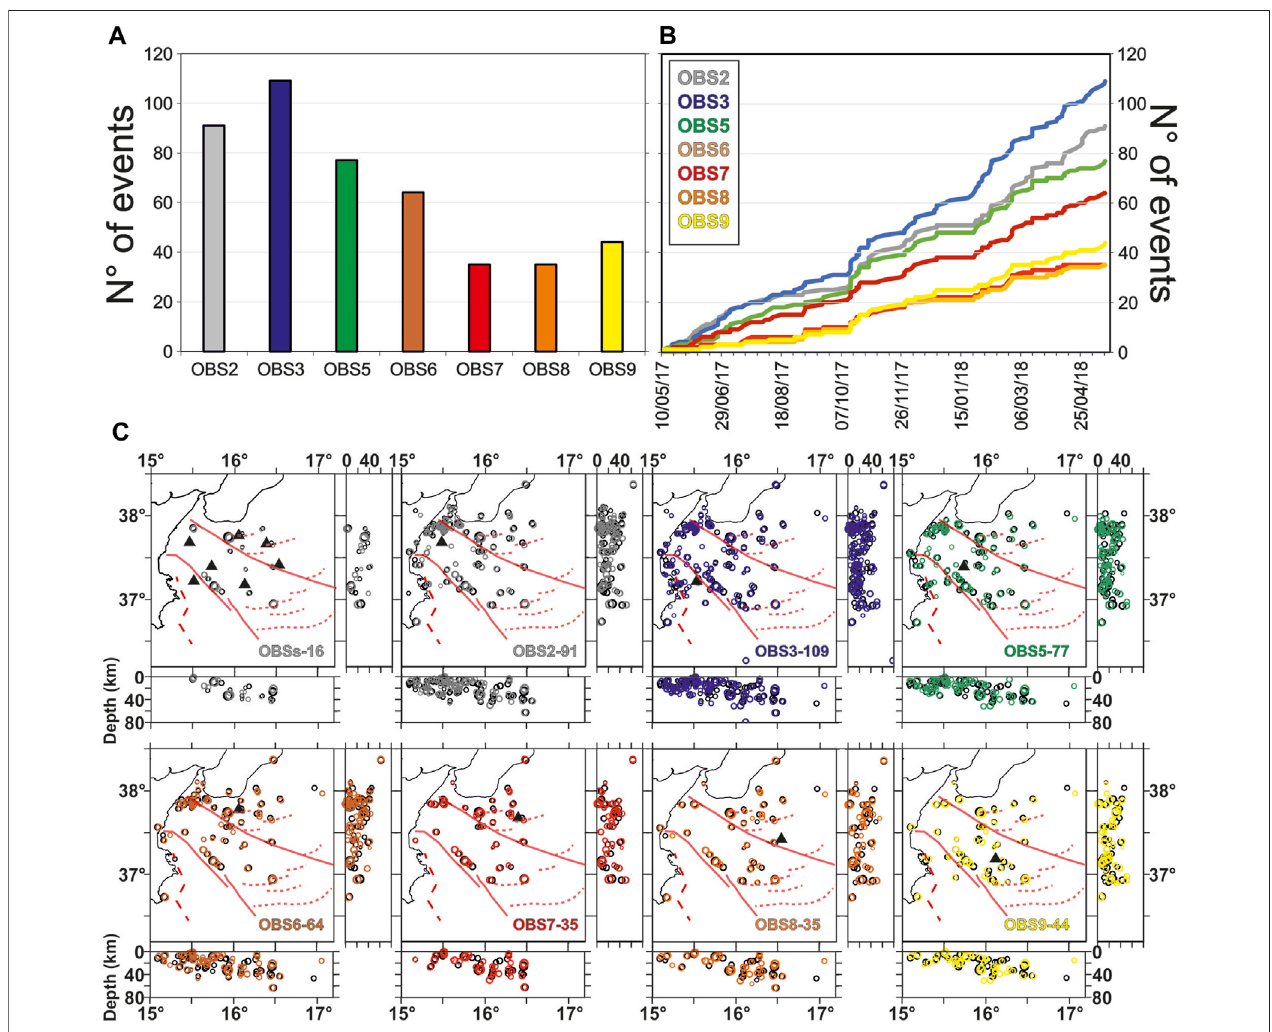
FIGURE 7 | Detection ef fi ciency of the OBS network for 133 local earthquakes located through the integration of travel times by marine and land stations (A) Histogramsand (B) occurrenceintimeofthenumberofearthquakesrecordedateachOBS (C) MapsandE-WandN-SsectionsofearthquakesrecordedbyeachOBS. Main geological features including the Alfeo-Etna Fault and Ionian Fault (Polonia et al., 2016) and the Malta Escarpment are sketched in red.